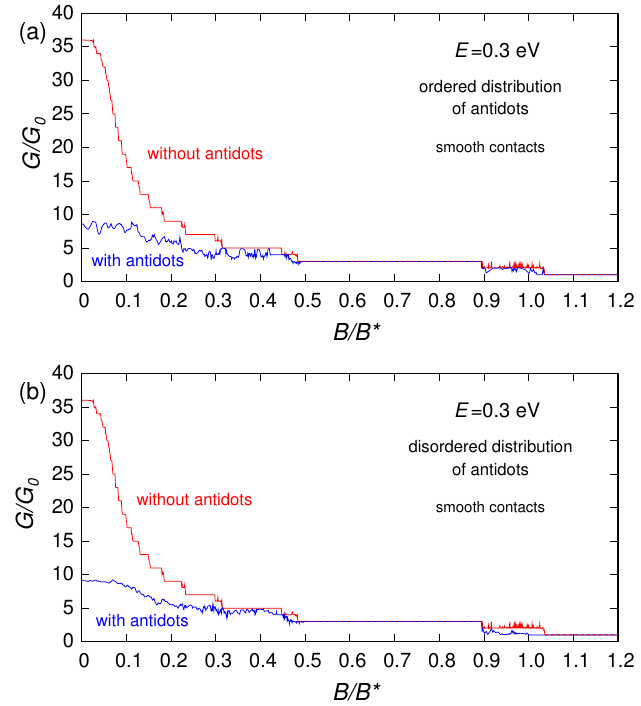
Figure 5. Normalized conductance of the graphene ribbon as a function of the orthogonal magnetic field (normalized with respect to B ∗ = 100 T), obtained for E = 0.3 eV in the presence of an ordered (panel ( a )) and a disordered (panel ( b )) distribution of antidots, compared with the conductance of the ribbon without